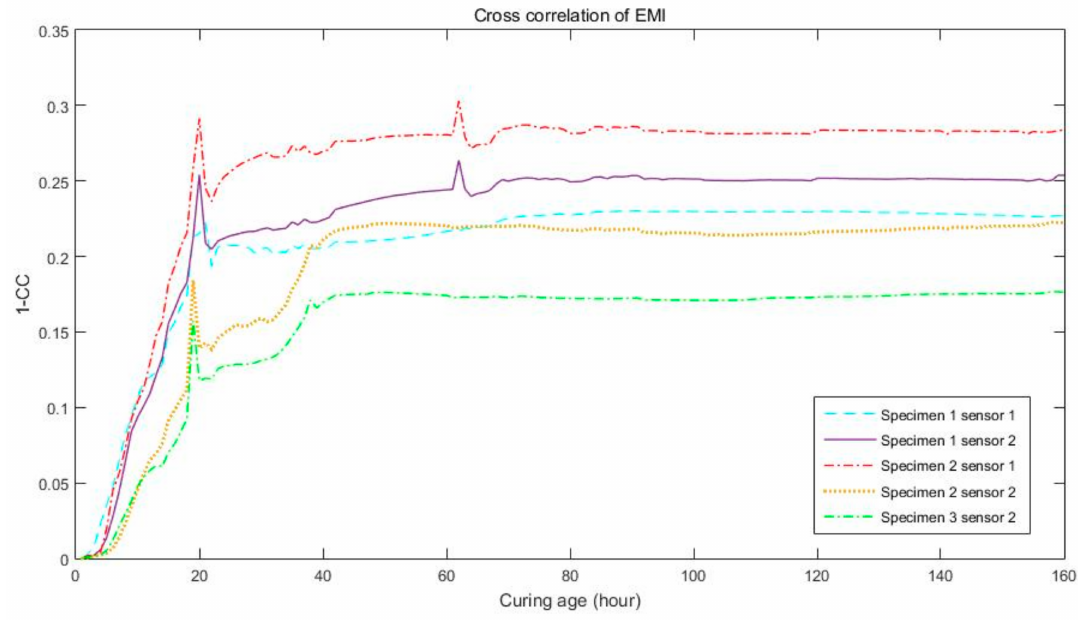
Figure 7. CC of the impedance data observed by five channels for seven